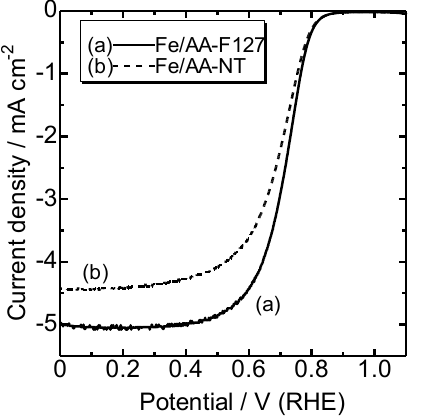
Figure 13. ( a ) FE-SEM image and ( b ) pore size distribution of mesoporous Fe/N/C catalyst [56].